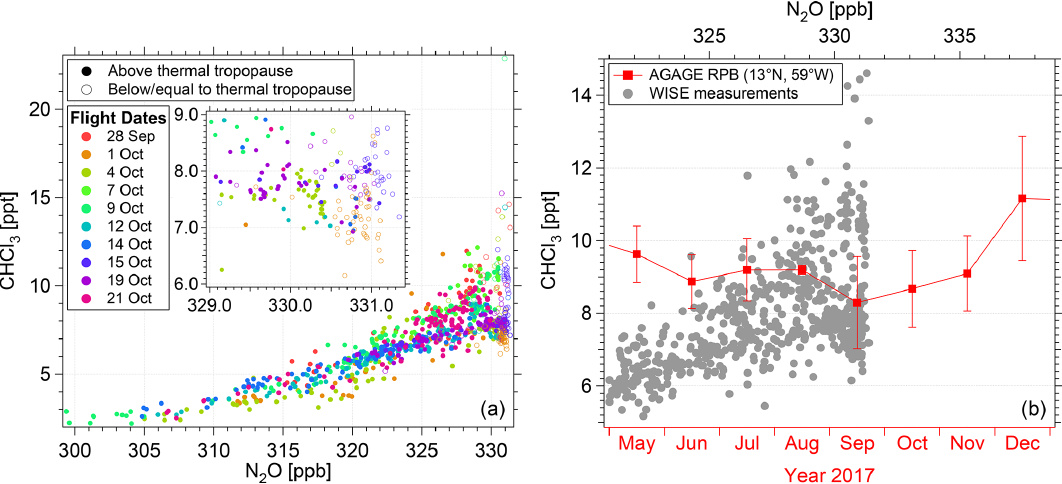
Figure C1. CHCl 3 –N 2 O relationship color coded by flight date (a) and monthly averaged ground-based measurements of CHCl 3 from the AGAGE network at Ragged Point, Barbados ( b ; Prinn et al., 2018), overlaid by a detailed plot of the CHCl 3 –N 2 O relationship. Panel (b) showing the CHCl 3 time series of the AGAGE network is similar to Fig. 4 where a detailed description is